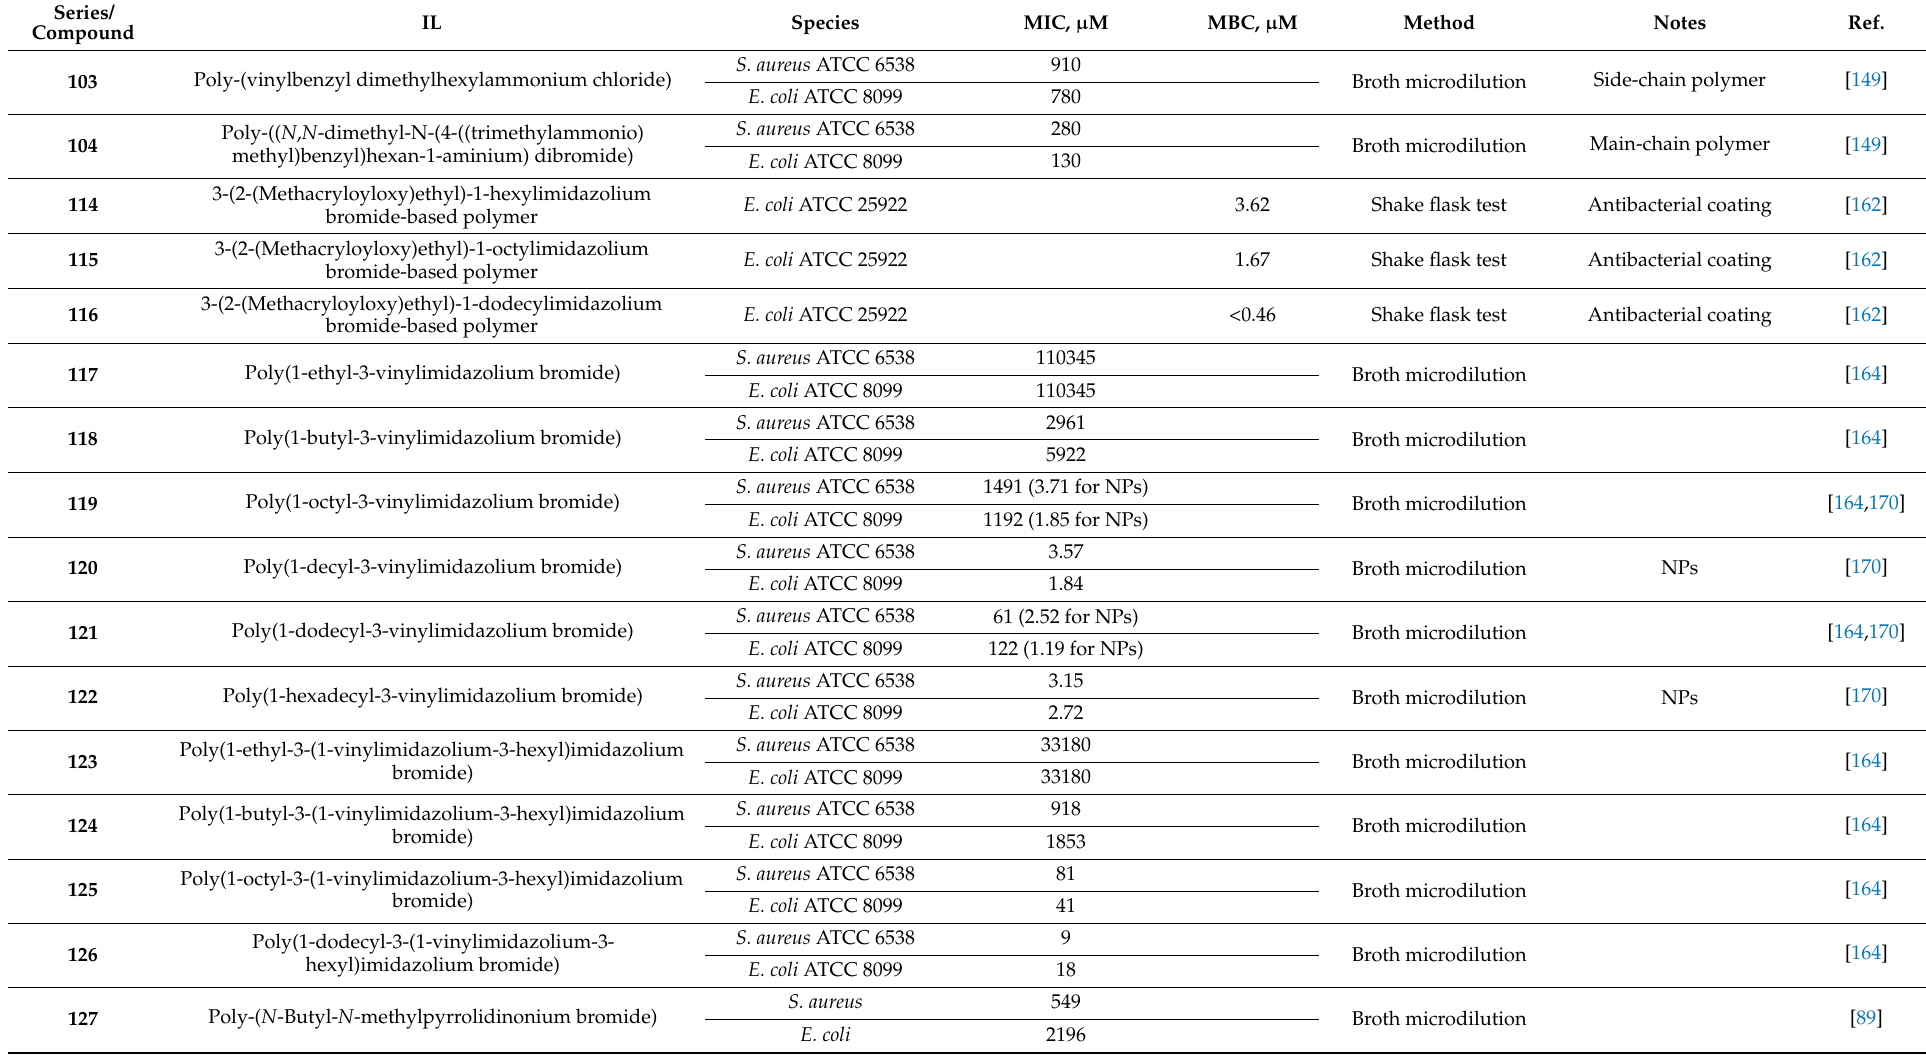
Table 8. Antimicrobial activity of poly-ILs